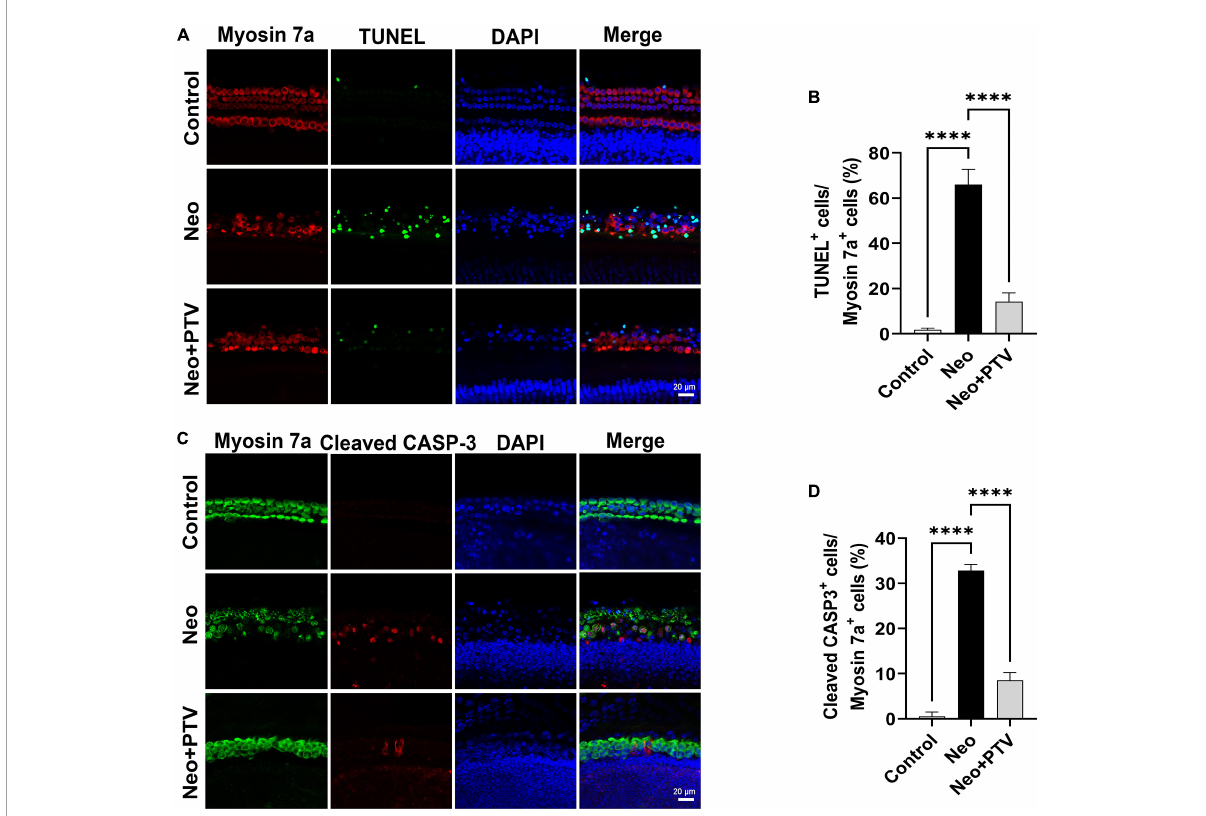
FIGURE4 Effects of PTV on apoptosis of cochlear hair cell in whole-organ explants induced by neomycin. (A) Immunostaining with TUNEL and myosin 7a labeling in the middle turns in cochlear explants. Scale bars = 20 µ m. (B) Statistics of the proportions of TUNEL highlighted hair cells in (A) . (C) Immunostaining with cleaved CASP-3 and myosin 7a in the middle turns in cochlear explants. Scale bars = 20 µ m. (D) Statistics of the proportions of cleaved CASP-3 highlighted hair cells in (C) . ∗∗∗∗ p <